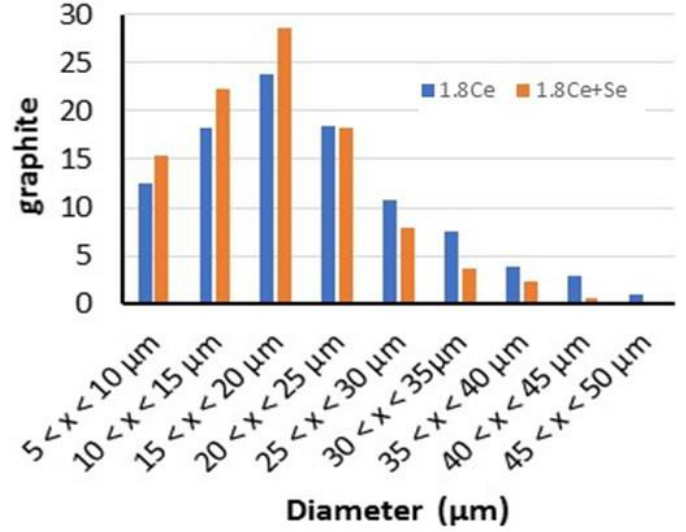
Figure 8. Influence of the addition of Se on graphite size distributions for TA cups from Heat 2.